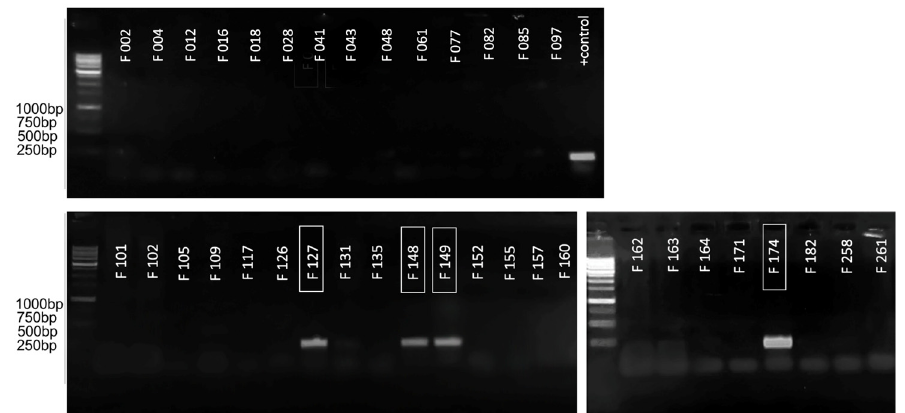
Figure 3. The results of conventional PCR visualised in 1.5% agarose gel. The numbers of the strains belonging to Ppa are marked with a frame. The remaining strains belonging to other species acted as negative controls. The lane designated as “+ control” contained PCR results with test plasmid, which served as a positive control. Evrogen 1 kb Ladder used for the evaluation of amplicons sizes.